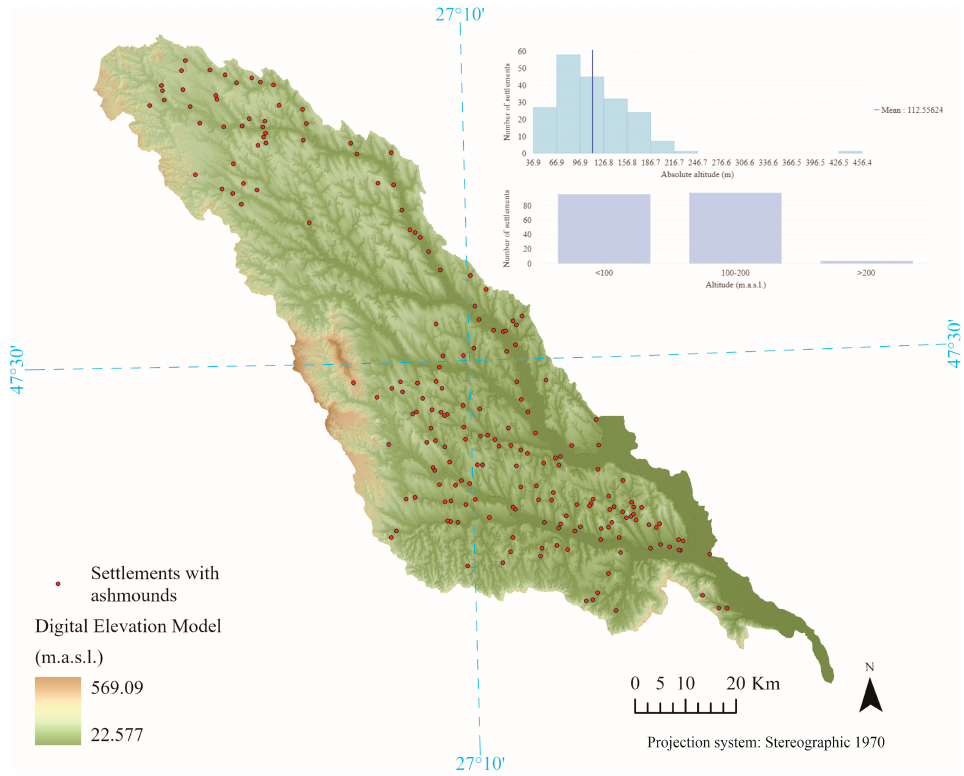
Figure 5. Noua settlements with ashmounds overlapped on hypsometric map, with graphs showing the altitudinal values of all the sites and their distribution within the main categories. Source of DEM: LiDAR-derived DEM from Romanian Water Administration, Prut-Bârlad branch, 1 × 1 m resolution.